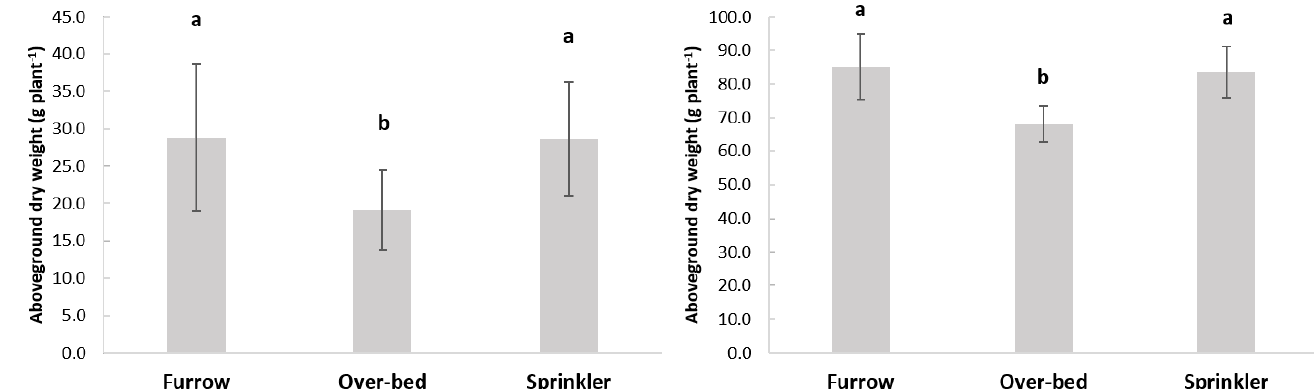
Figure 13. Average aboveground biomass of the irrigation treatments tested in experiment 5 on 5 March ( left ) and 29 March ( right ) 2018. Different letters between irrigation treatments indicate statistically significant differences at p < 0.05.